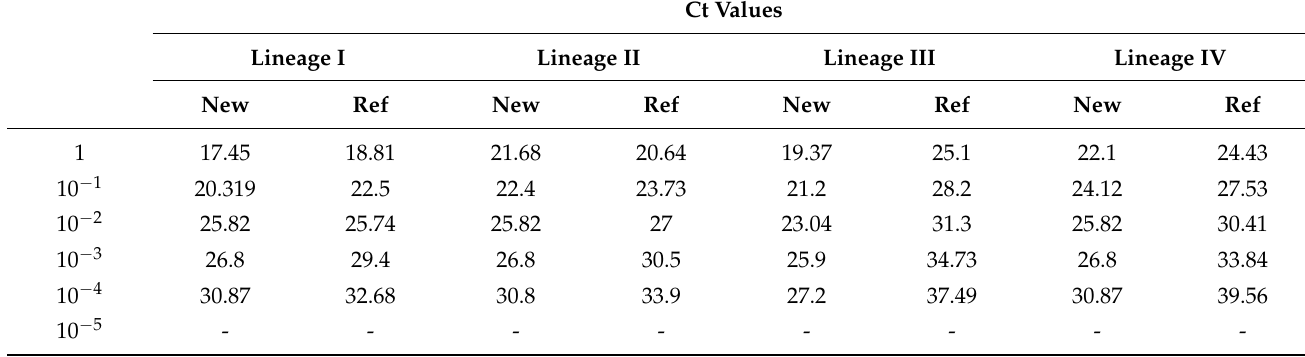
Table 1. Comparative Ct values that were obtained for PPR XF and reference assays. All four lineages of PPRV ((I—Ivory Coast/89, II—Nigeria/75/1, III—Sudan/72, and IV—Morocco/2008)) were normalized to a titre of 4.7 log 10 TCID 50 /mL. Crude virus was used in the newly-designed assay (New), whilst RNA was extracted for use in the previously published reference assay (Ref) [26]. In both assays, the template was serially diluted neat to 10 − 5 to generate a standard curve. The samples denoted (-) refers to the sample failing to